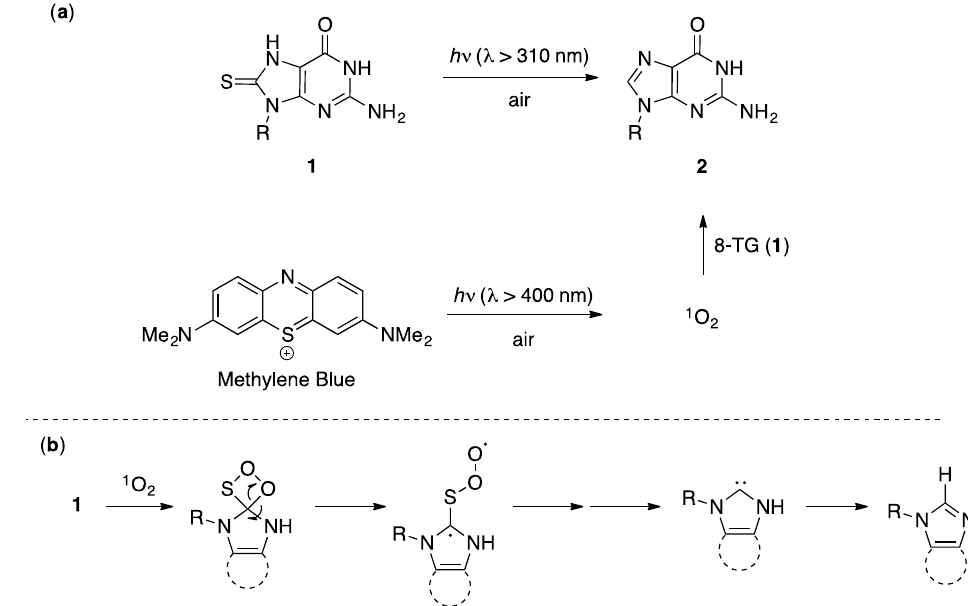
Scheme 3. ( a ) Photochemical oxidation of 8-TG and photosensitized generation of singlet oxygen; ( b ) Proposed mechanistic pathway of the 1 O 2 -promoted desulfurization of 8-TG.